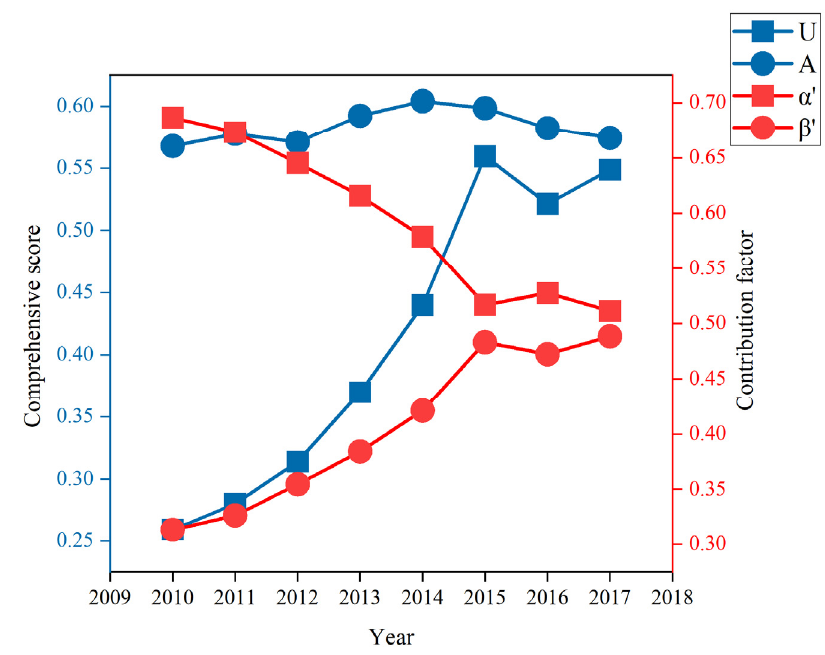
Figure 6. Changes of the improved contribution coefficient.